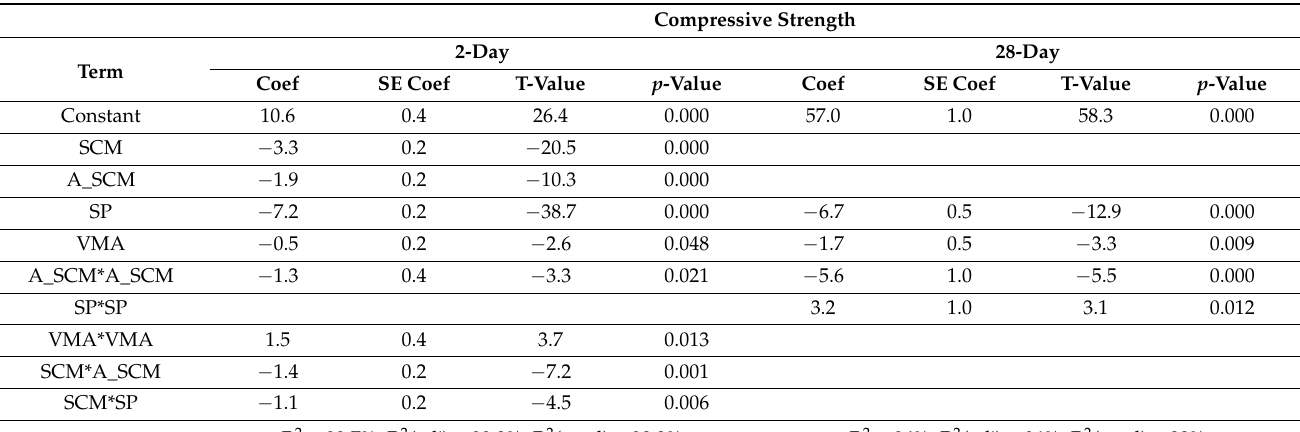
Table 9. Regression coefficients, standard error of the coefficients, T-values, and p -values of the factors affecting 2-day and 28-day compressive